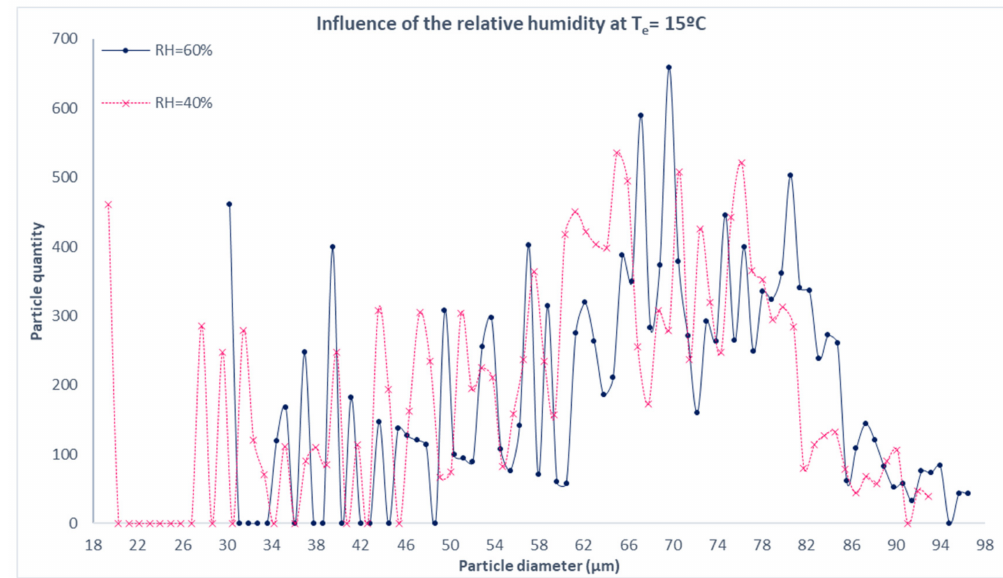
Figure 7. The distribution of the droplets size at t = 2.5 s when the environment temperature was 15 ◦ C. Comparison between RH = 40% and RH = 60%.